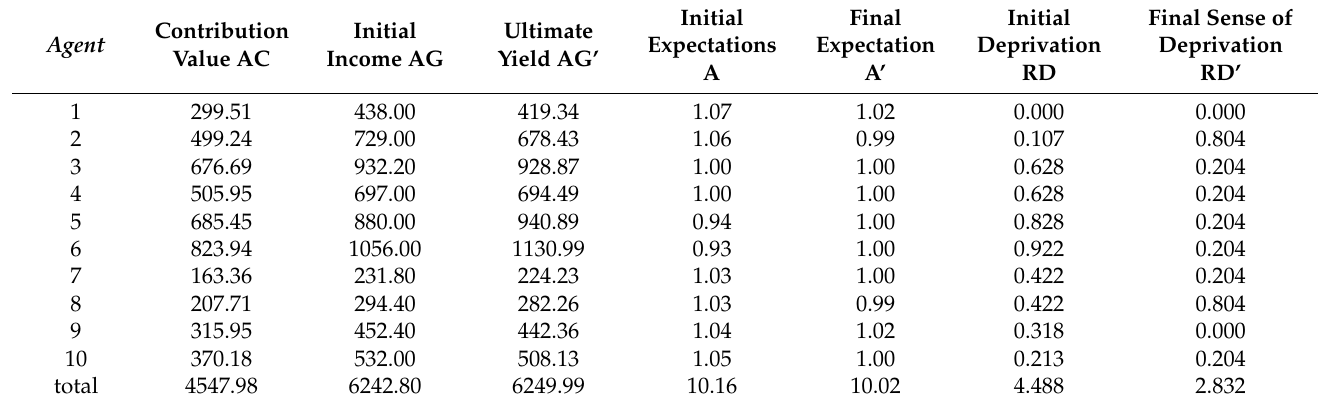
Table 5. Result of benefit distribution after adjusting parameters.